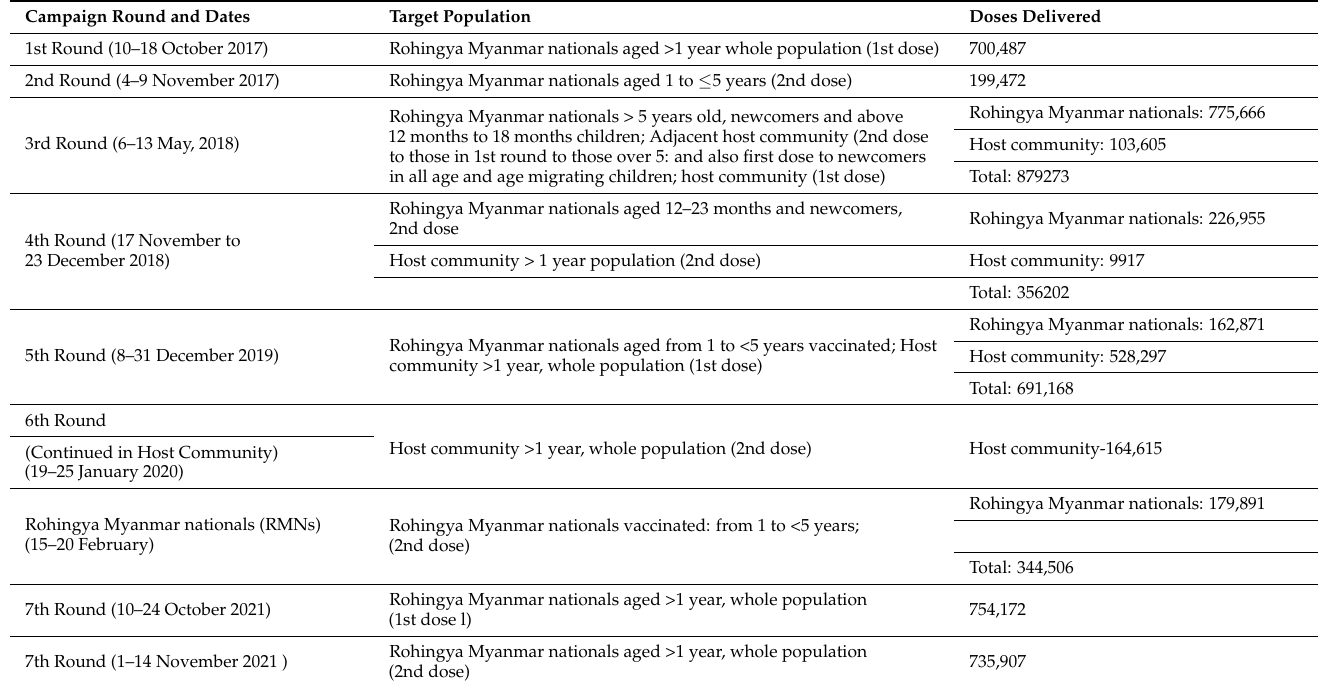
Table 1. Vaccination status and target